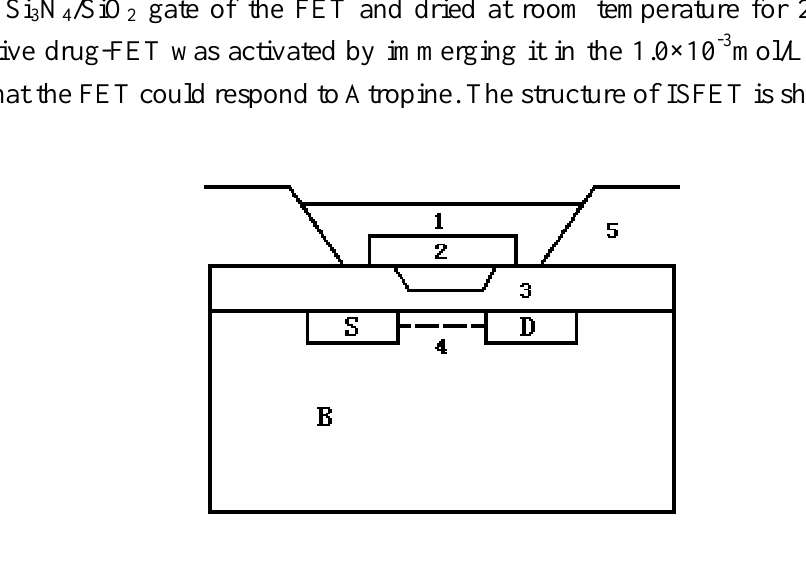
Figure 1. Structure of ISFET. S: source; D: drain; B: p-silicon; 1- drug sensitive N ; 3 - SiO ; 4 - n-channel; 5 - silicone membrane; 2 - Si 3 4 2